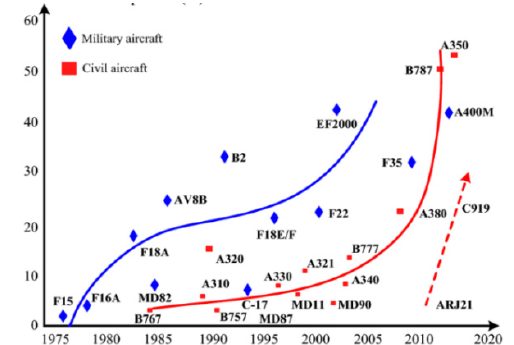
Figure 1 Application of composites on military and civil aircraft